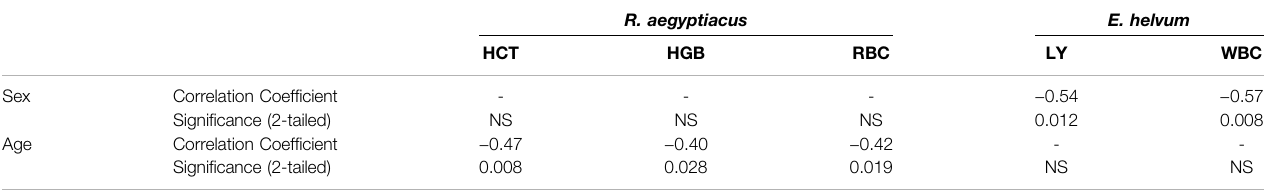
TABLE 3 | Correlation of hematological parameters to age and sex of R. aegyptiacus and E. helvum